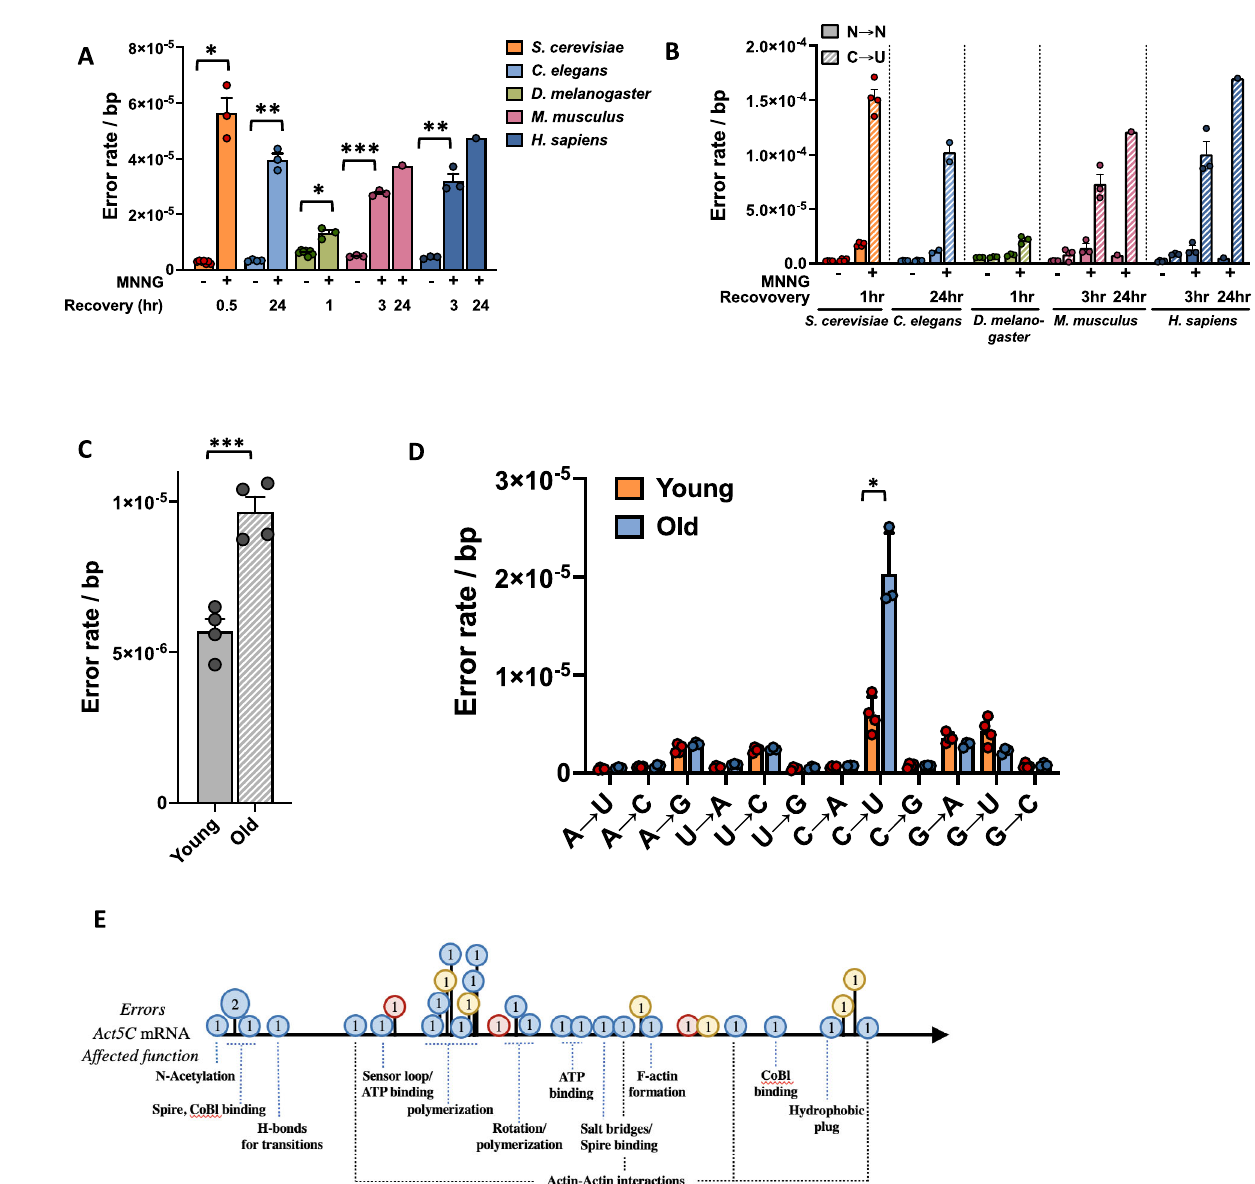
Fig. 5 | The error rate of transcription in multiple organisms of increasing complexity.A MNNGelevatestheerrorrateofRNAPIIinyeast( n =7foruntreated cells and n =3 for treated cells, P =0.0104), worm ( n =4 for untreated worms and n =3 for treated worms, P =0.0036), fl y ( n =7 for untreated fl ies and n =3 for treated fl ies, P =0.0193),mouse( P =0.0002)andhumancells( P =0.0075) n